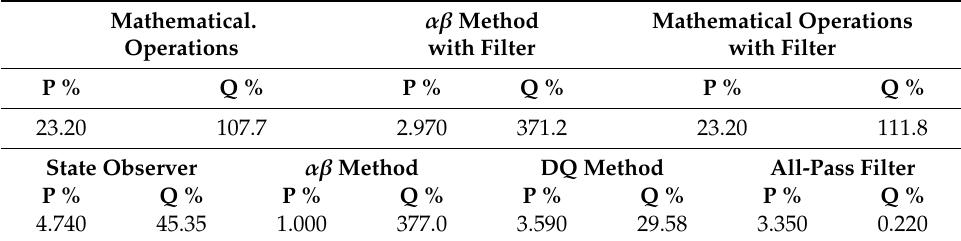
Table 5. Error percentage for each method—non-linear load.